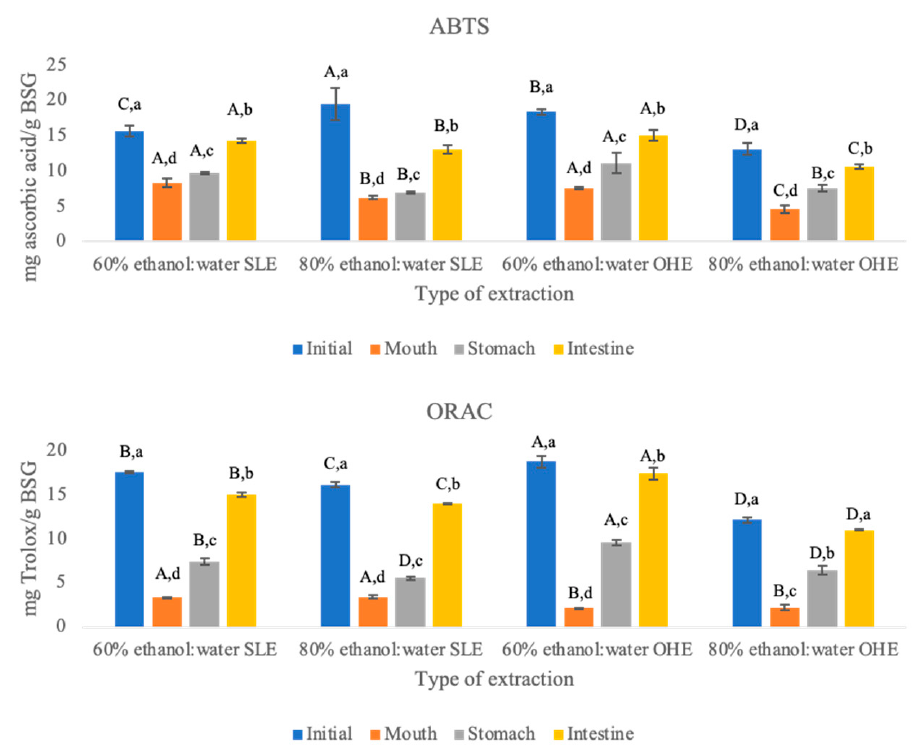
Figure 1. ABTS and ORAC values of brewer’s spent grain solid residues (from solid-liquid extraction (SLE) and ohmic heating extraction (OHE)) throughout GID. Different letters mean significant differences ( p < 0.05). The capital letters indicate the differences among the different extracts at the same GID phase, and the lowercase letters indicate the differences between GID phases for each residue of extraction. N.D = Non detected.